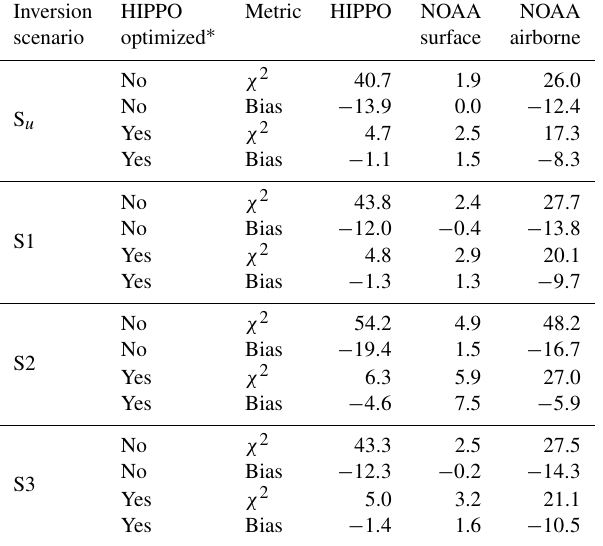
Table 5. χ 2 metrics and mean biases for the different inversion scenarios. Statistics are shown for the NOAA surface stations, the HIPPO campaigns and the NOAA airborne profiles. Biases are given in pmolmol − 1 .